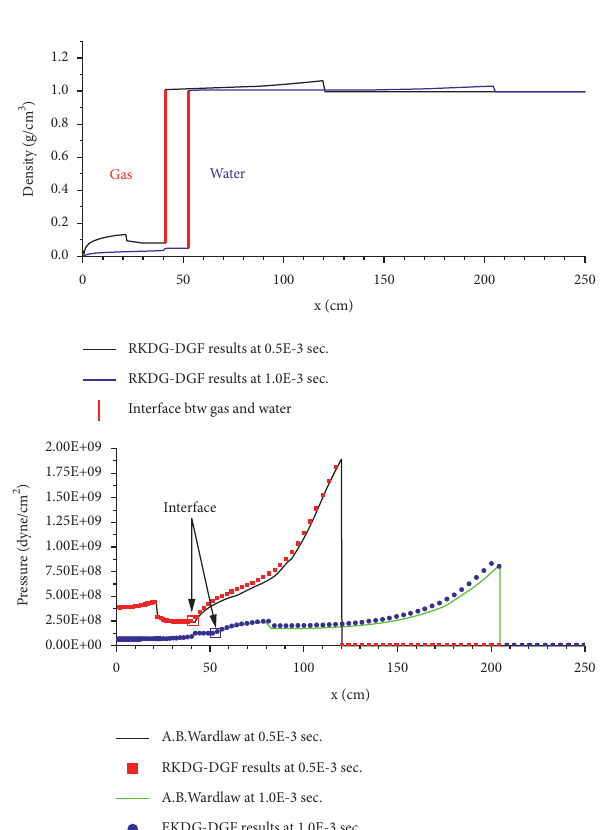
Figure 8: RKDG-DGFM results of Case 2 at 0 . 5 × 10 − 3 and 1 . 0 × 10 − 3 seconds.